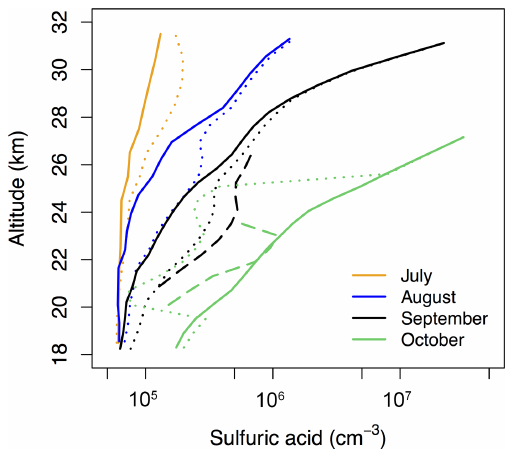
Figure 4. Combination of the nucleation threshold sulfuric acid pro- files from Fig. 1b (solid) and the CN layer sulfuric acid profiles from Fig. 3a (dashed). Additionally, we show sulfuric acid profiles that cause a CN increase in our CN simulation of Fig. 3b (dotted) which should represent upper limits of the Antarctic winter stratospheric sulfuric acid outside the CN